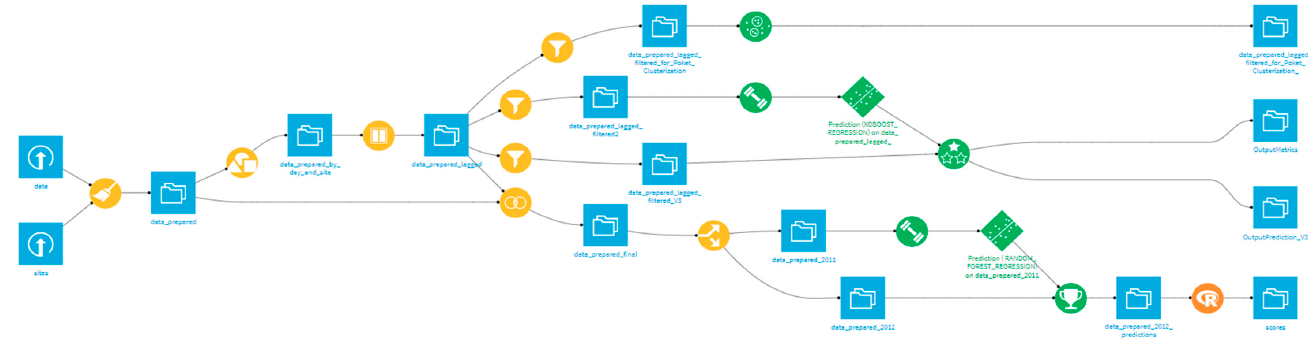
Figure 12. Data flow.